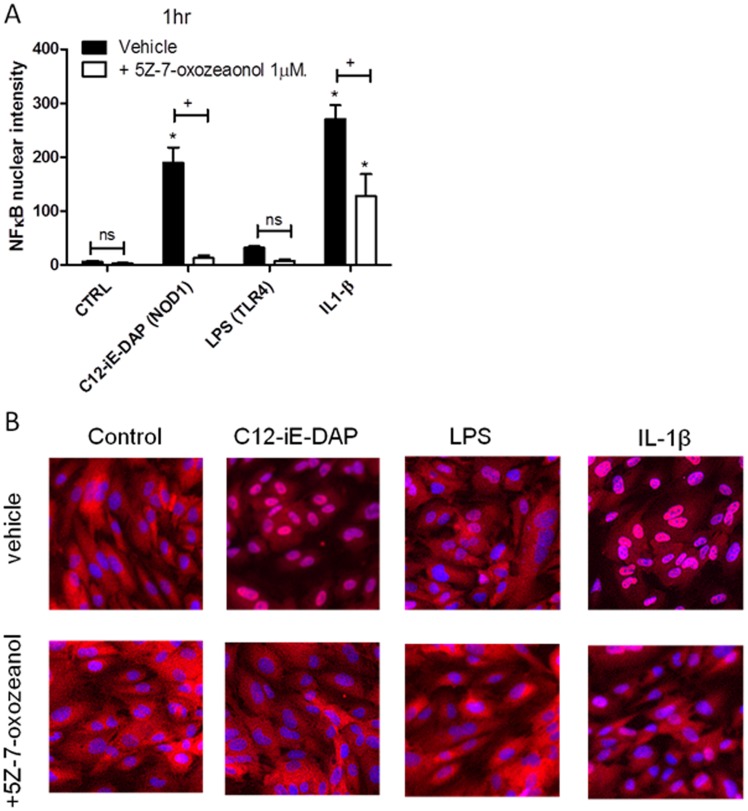
NOD1 or TLR4 ligand and TAK1 mediated NFκB activation in HMVEC.(A) Mean NFκB nuclear intensity/cell (normalised to 1000 cells) following stimulation with C12-iE-DAP 10 µg/ml (NOD1 agonist), LPS 10 µg/ml (TLR4 agonist) or IL-1β 1 ng/ml for 1 hour in the presence or absence of the TAK1 inhibitor 5Z-7-oxozeaonol. Results are mean ± SEM n = 6. Data was analysed by one-way ANOVA followed by Bonferroni’s Multiple Comparison Test (*P<0.05 vs. CTRL) or by two-way ANOVA followed by Bonferroni’s post tests (+P<0.05 vs. vehicle). (B) Representative images of NFκB nuclear translocation under the different experimental conditions.